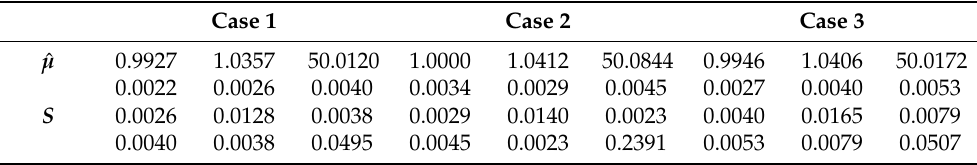
Table 7. ˆ µ and S estimates from the phase-I sample for the three cases under